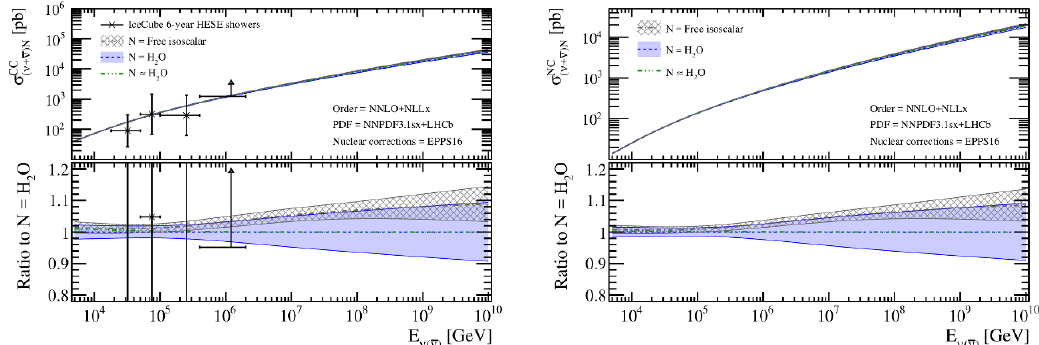
Figure 16 . The BGR18 predictions in the n f = 6 FONLL scheme at NNLO+NLL x accuracy as a function of E (cid:23) in the CC (left) and NC (right plot) cases for two di(cid:11)erent targets: a free isoscalar nucleon (without nuclear modi(cid:12)cations) and an H 2 O target (with the EPPS16 nuclear modi(cid:12)cations). In the lower panel, we show the same results normalised to the central value of the BGR18 calculation for an H 2 O target. In the CC case, we also compare our predictions with recent IceCube measurements based on the 6-year HESE shower dataset